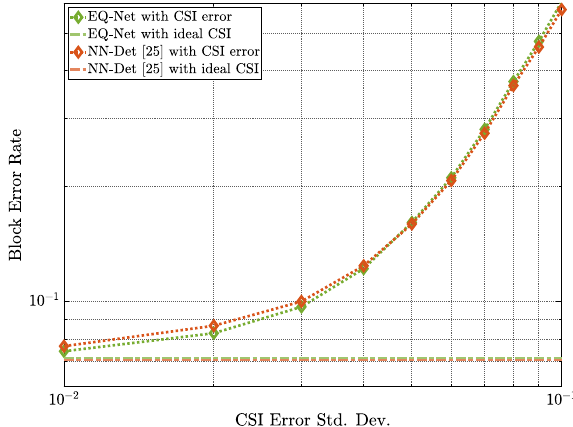
Fig. 4 Estimator robustness of EQ-Net (L), and the similarly performing NN-Det (P) under imperfect CSI for 2 × 2 , 64-QAM, i.i.d. Rayleigh fading, and LDPC-coded with size (324, 648). The plot shows the coded block error rate at SNR 17.3 dB as a function of the CSI error. The two horizontal lines show the average = end-to-end performance of the two algorithms with ideal CSI knowledge at the same SNR